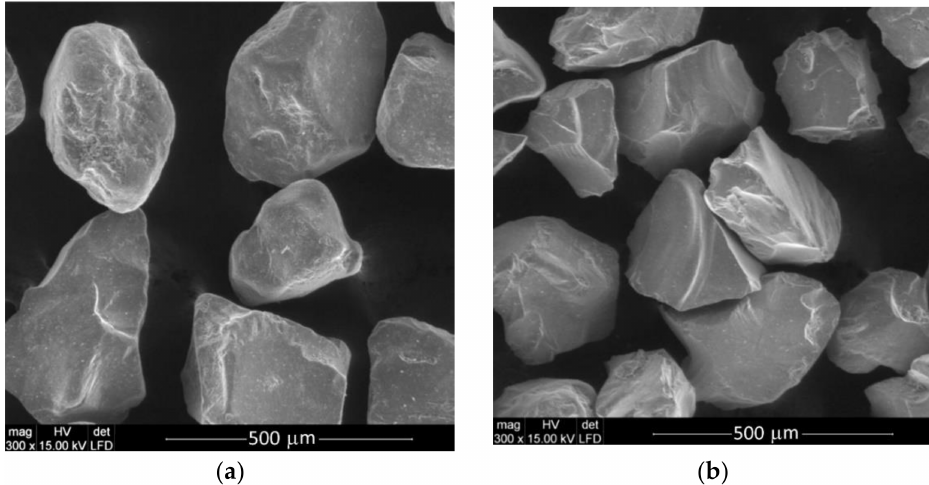
Figure 2. Exemplary scanning electron microscope (SEM) view of garnet abrasive material: ( a ) fresh, before AWJ machining process; ( b ) recycled after AWJ machining process. Magnification 300 ×